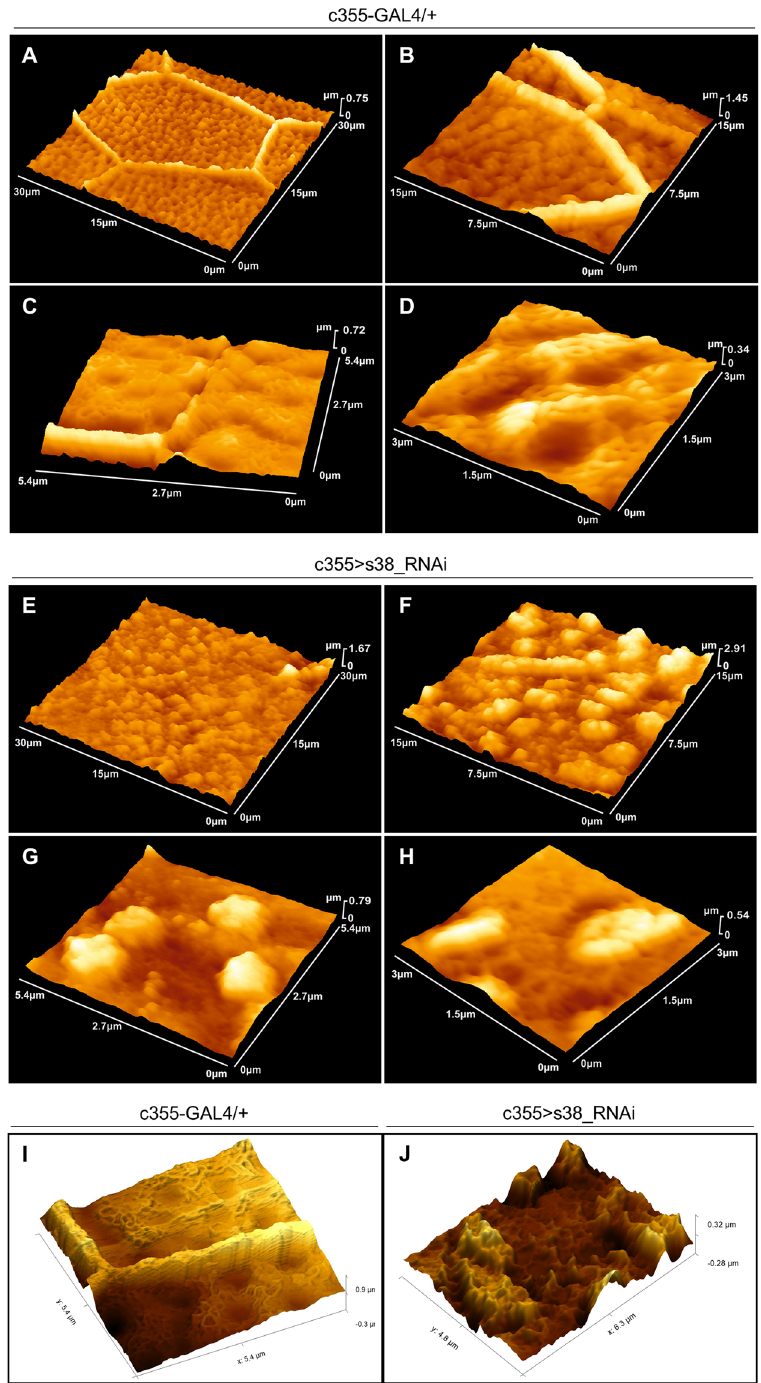
Figure 5. AFM-mediated topography of surface deformities in s38-targeted laid eggs. ( A – D ) Atomic-force- microscopy (AFM) imaging of control (c355-GAL4/ + ) (laid-egg) eggshell-surface topography, in increasing magnifications, illustrating the characteristic follicular-imprint hexagonal pattern ( A – C ). ( D ) Inside view of a hexagonal area, where, in a canonical distribution, dimple-like structures are self-assembled in a hill- and-valley arrangement. ( E – H ) AFM analysis of s38-downregulated (c355 > s38_RNAi) eggs, in increasing magnifications, unveils a severely disorganized eggshell surface that lacks the typical follicular imprints. In addition, the hill-and-valley/dimple patterns of control eggs are replaced by unevenly distributed granular structures. ( I , J ) Enhanced images of control ( I ) and s38-targeted ( J ) eggs, using the Gwyddion visualization software, demonstrating the fibrillary organized surface of control egg, within its hexagonal area ( I ), in contrast to the randomly organized granular surface of a representative s38-targeted ( J ) one. Number of eggs examined: control = 8, s38-downregulated =